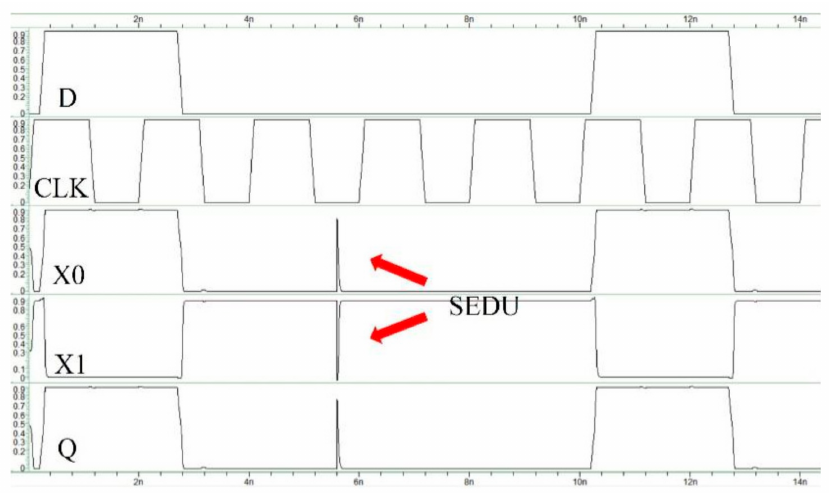
Figure 11. Simulation result during (X0, X1) SEDU injection. For the logic error caused by an SET, the input signal was inverted. This error first upset X0 and X2, and then the output value had a transient upset. As shown in Figures 12 and 13, when D was 0 and inverted by the transient pulse, it propagated to X0 and X2. If it was propagated to the output, node A and node B must have been discharged first. Similarly, when D was 1, it was affected by transient pulse. If this affects the output, the structure must discharge node A of the cross-coupled element C1. C1 was recovered because X0 recovered through X3 in a short time. The simulation result was similar to X0 and X2 upsets. Similarly, the upset of the node pairs <X1, X3> was similar to <X0, X2>, the upset of the node pairs <X0, X3>, <X1, X2> and <X2, X3> were similar to <X0, X1> The peak value of the fault injection was 0.9 V, the rise time was 0.02 ns, and the fall time was 0.1 ns.